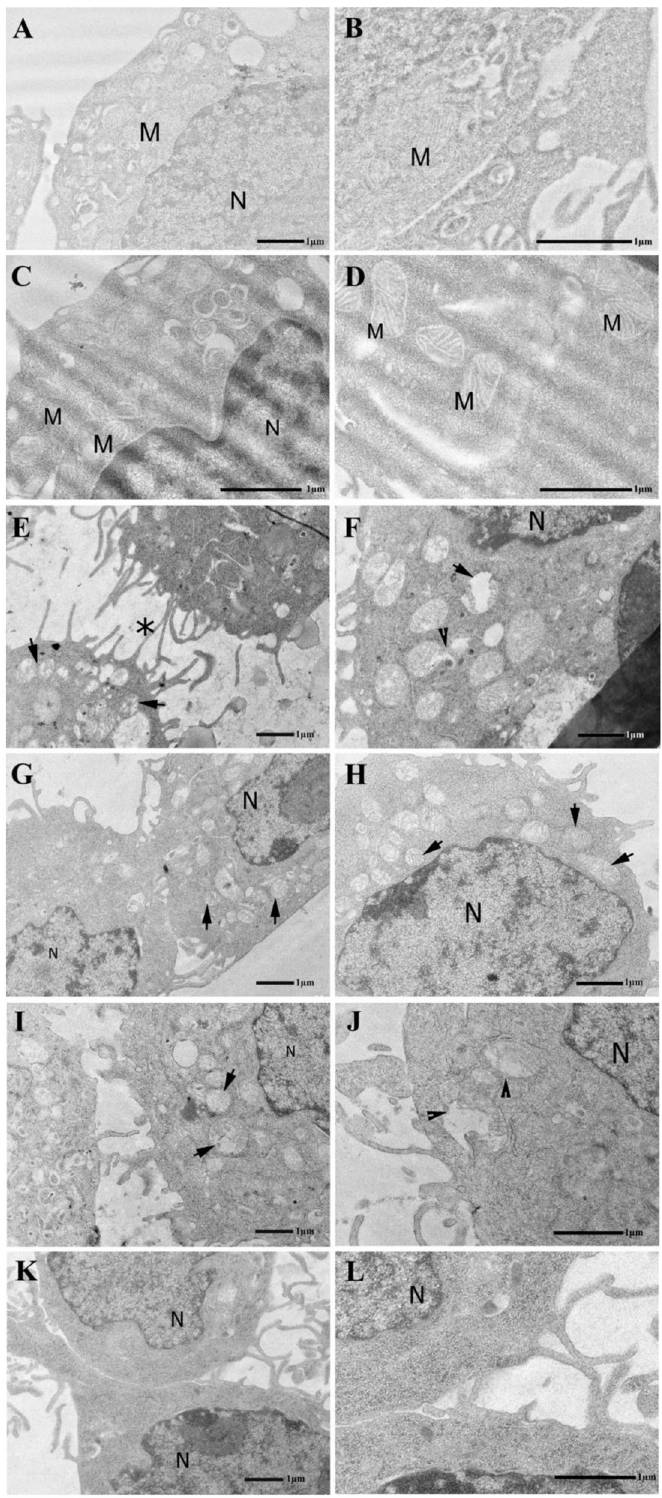
Figure 4. Electron micrographs of J774cells. ( A , B ) The Control group displays a well-preserved ultrastructure. ( C , D ) Administration of T β 4 (10 µ M, 24 h) does not appear to alter cell morphology. Note in both control and T β 4 treated samples the presence of several mitochondria showing a continuous mitochondria membrane and well-organized cristae. M = mitochondria, N = nucleus. ( E , F ) Glutamate treatment (5.5 mM, 24 h) induces numerous cellular alterations that affect especially